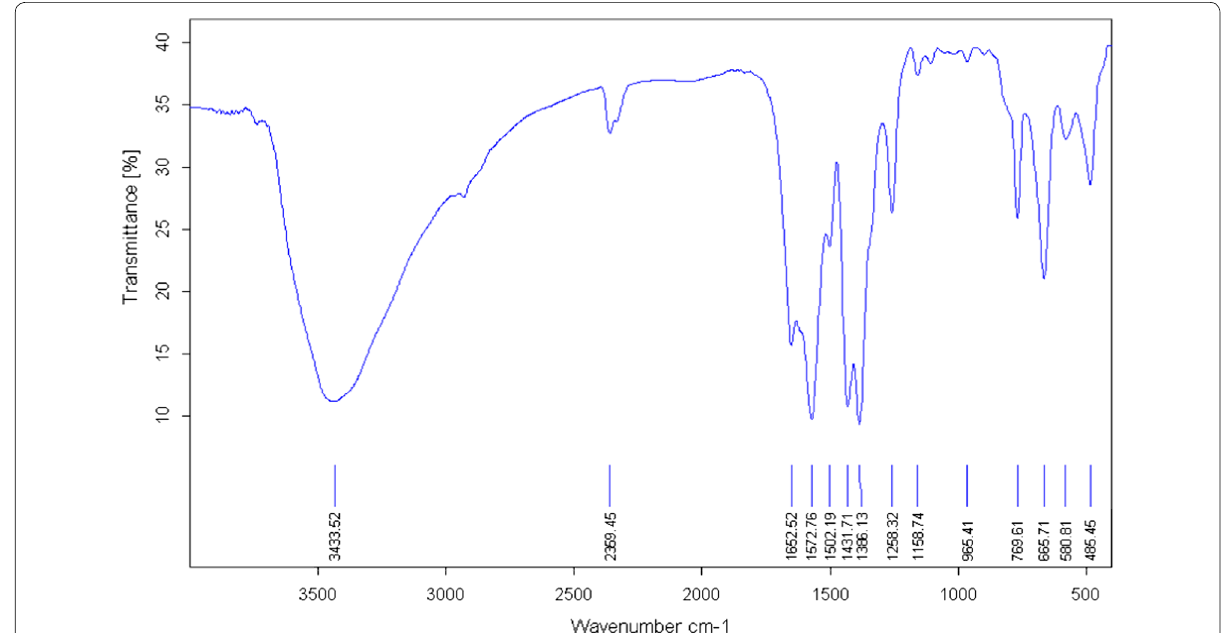
Fig. 2 FTIR spectrum of synthesized